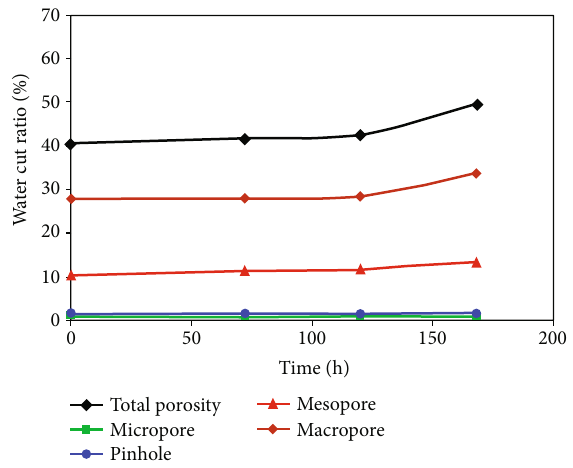
Figure 9: Variation curve of water cut of di ff erent types of pore- throat in core 2 with imbibition